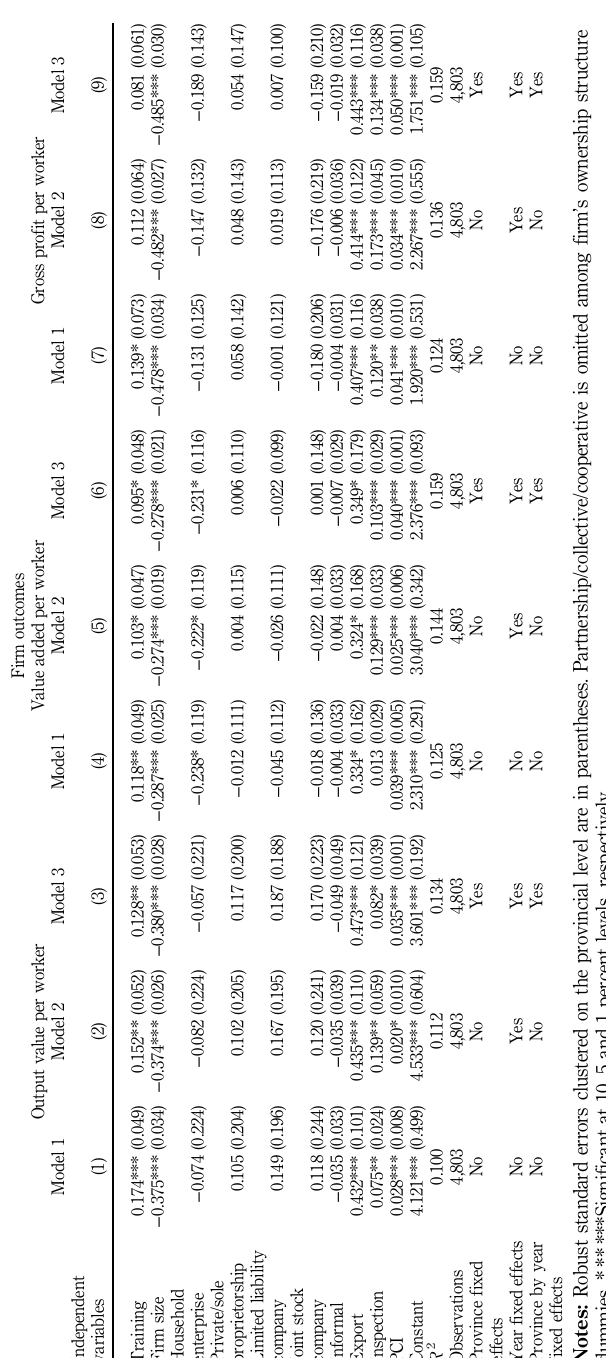
Table II. Training (yes/no) and firm